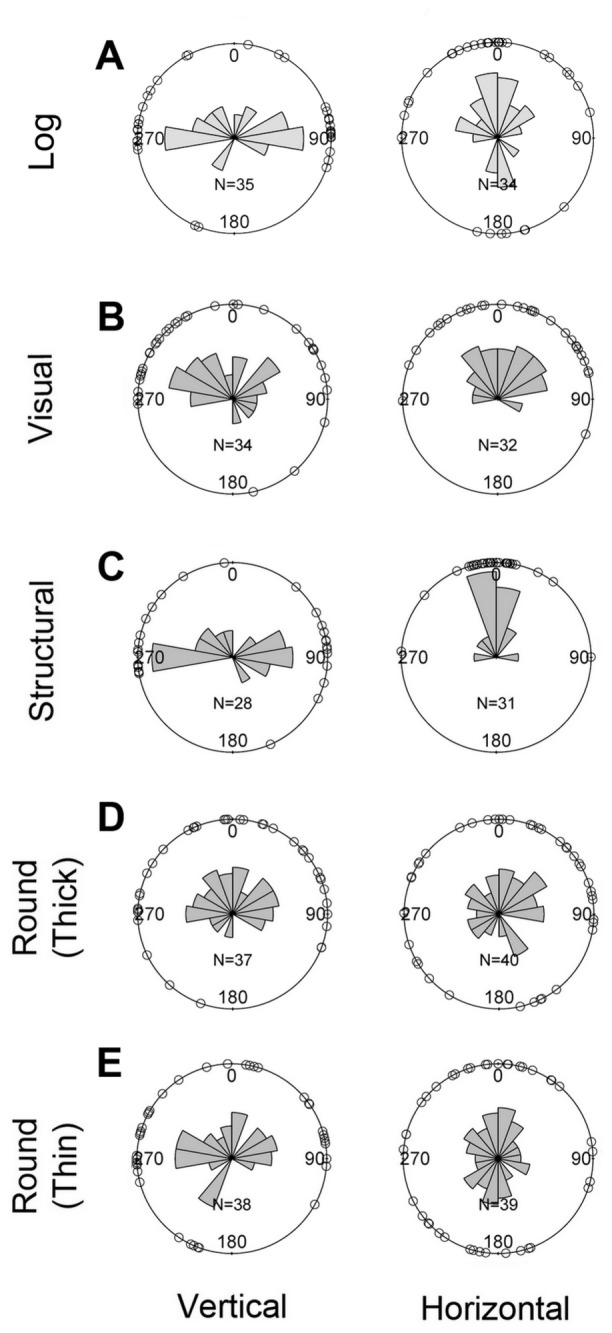
The angular distributions of transformed body orientations of moths in the experiments.The figures show the body orientation of moths on the log (A), and the background with visual cues (B; experiment 2), structural cues (C; experiment 3), low curvature cue (D; experiment 4), and high curvature cue (E; experiment 4). The rose diagrams (i.e. histogram of directions) show the relative frequency of moth’s head pointing towards the direction of the bar.